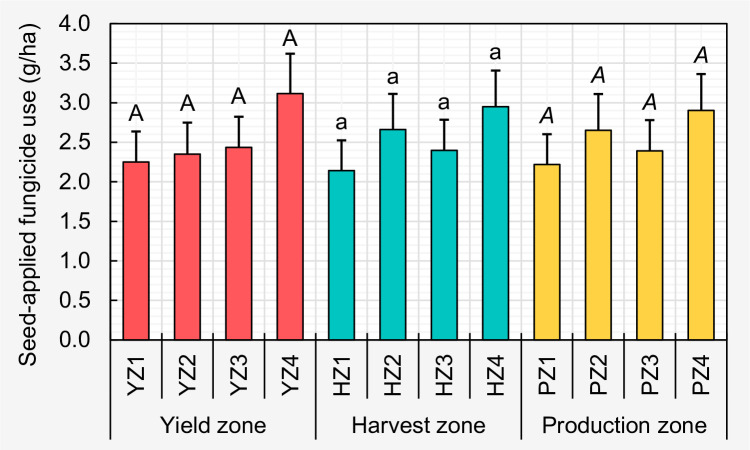
Comparison of the mean per hectare seed-applied fungicide use (in g) among yield/harvest/production zones.Within each zone type, means followed by a common letter are not significantly different after adjustment for multiple comparisons using Tukey-Kramer test at the 5% level of significance. Error bars represent standard errors. The fungicides included: fludioxonil, mefenoxam, and metalaxyl. The selected fungicides are effective against Fusarium wilt, Phytophthora root and stem rot, and seedling diseases caused by Fusarium, Phomopsis spp., Pythium, and Rhizoctonia solani.